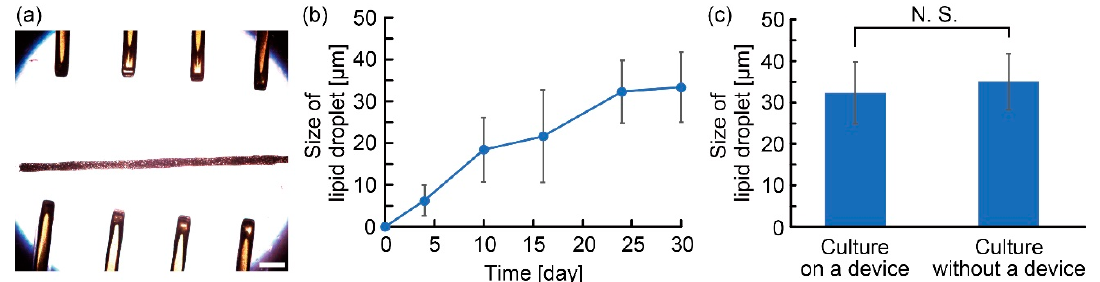
Figure 8. Observation of an adipocyte microfiber cultured on the anchoring device: ( a ) Images of an adipocyte microfiber on day 28; ( b ) Size of lipid droplets varying with time (n ≥ 10, mean ± s. d.); ( c ) Comparison of lipid droplet size in adipocyte microfibers cultured with or without the anchoring device for 24 days (n = 20, mean ± s . d.). Scale bar is 500 µm.